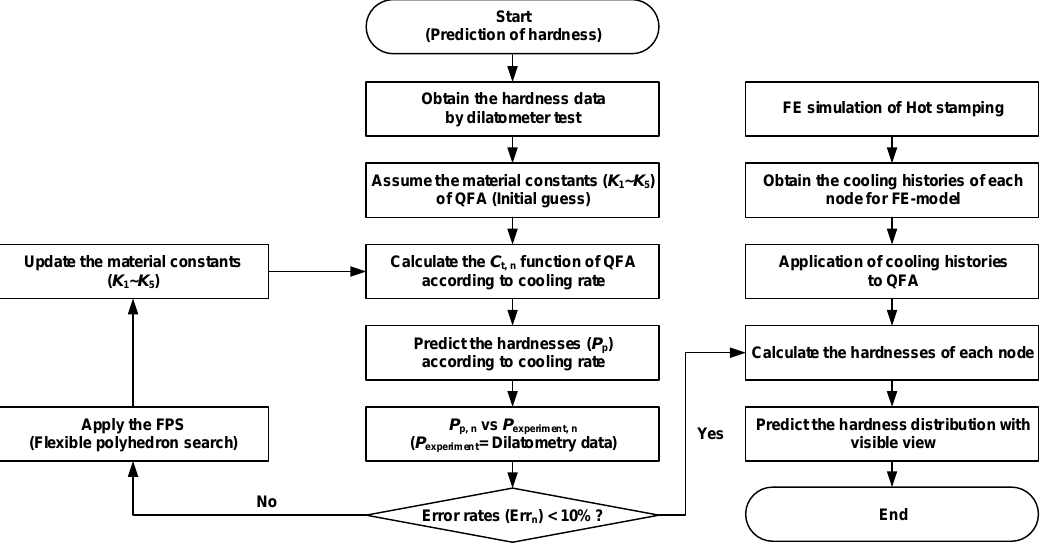
Figure 5. Flow chart for the prediction of the hardness coupled with finite-element (FE)-simulation.